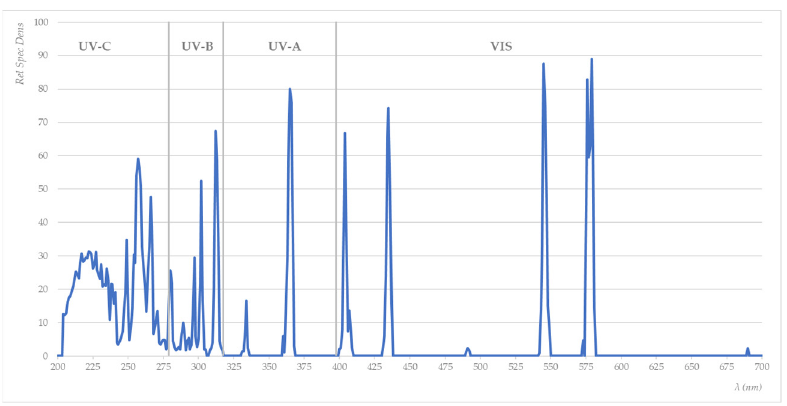
Figure 11. Relative spectral density (RSD) of a halogen quartz glass heater.